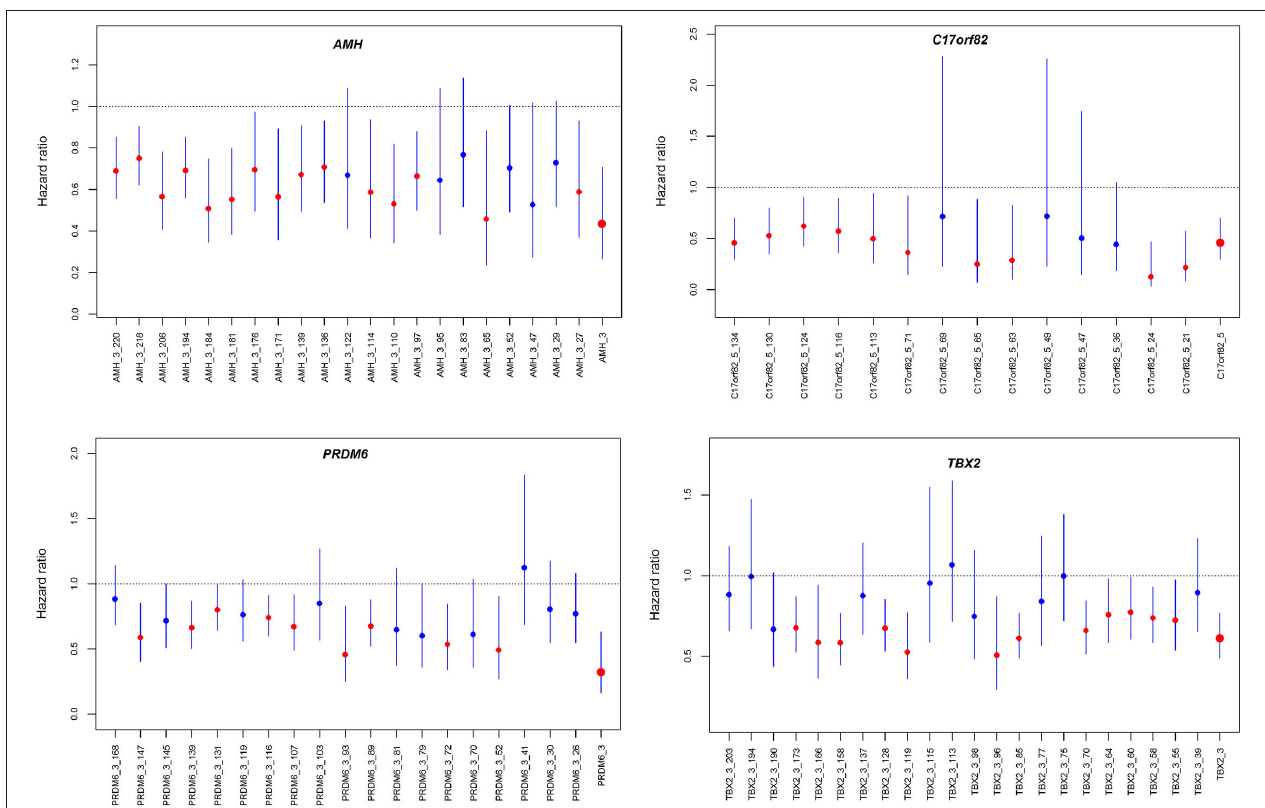
FIGURE 4 | Hazard ratios for the association between DNA methylation and 3-month mortality. The four panels show the hazard ratios for each of the CpG sites in the four genes assessed by Cox proportional hazard models. The associations were adjusted for